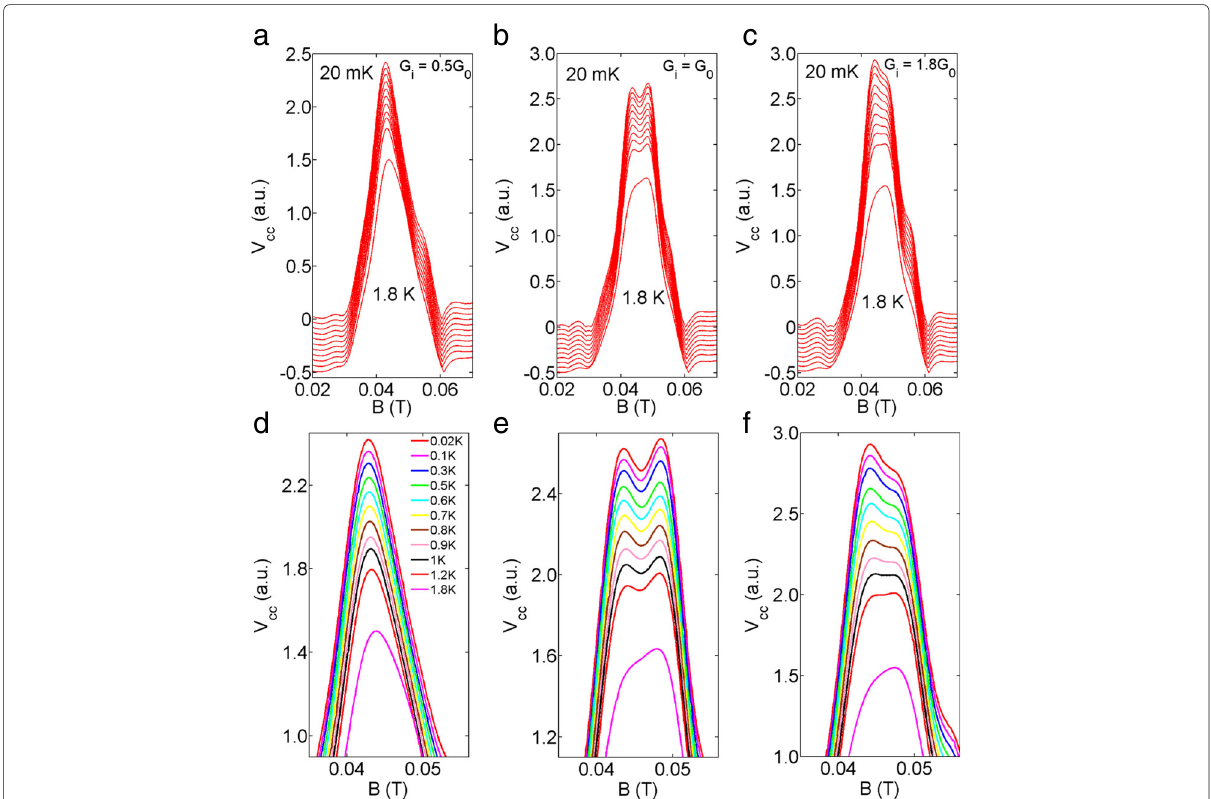
Fig. 3 Temperature dependence of TEF. a – c The injector was set to 0.5 G 0 , G 0 and 1.8G 0 , respectively. The lattice temperature was incremented from 20 mK (top trace) to 1.8 K (bottom trace). Data have been offset vertically for clarity. d - f , zoom-in of the data in ( a )-( c )